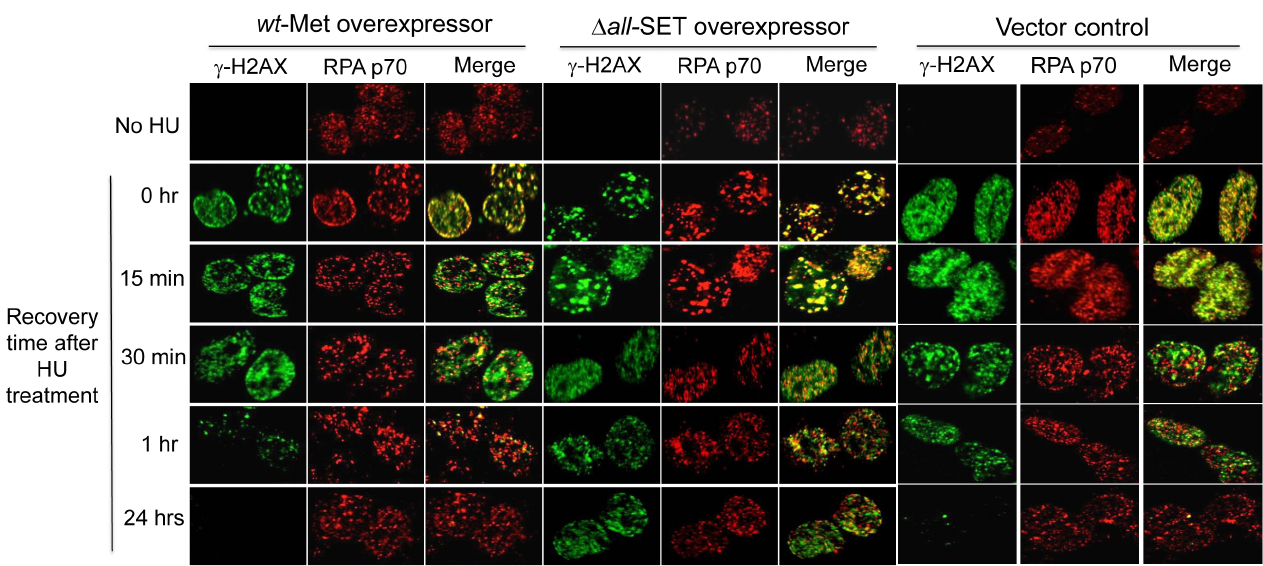
Fig 2. The Metnase SET domain is necessary for Metnase function in damage recovery prior to replication restart following HU treatment. Representative images of γ -H2AX and RPA p70 foci in HEK293 cells stably transfected with pCMV4 vector, wt-Metnase, and the SET deletion mutant ( Δ all - SET), as indicated on the top. After treatment with 2 mM HU for 3 hrs, cells were released into fresh media at indicated times, stained with DAPI (blue) and antibodies to γ -H2AX (green) and RPA p70 (red), and imaged by confocal